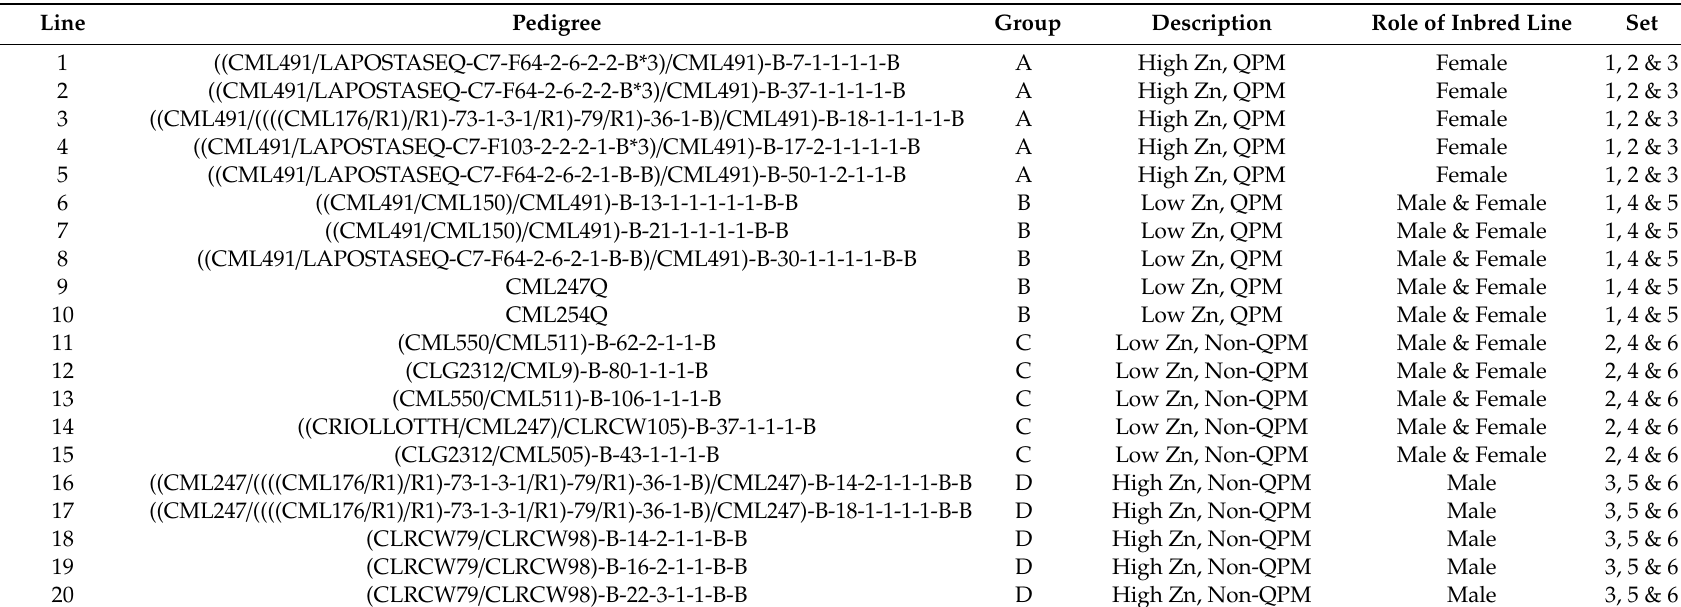
Table 1. List of 20 elite maize inbred lines used as parents for the mating